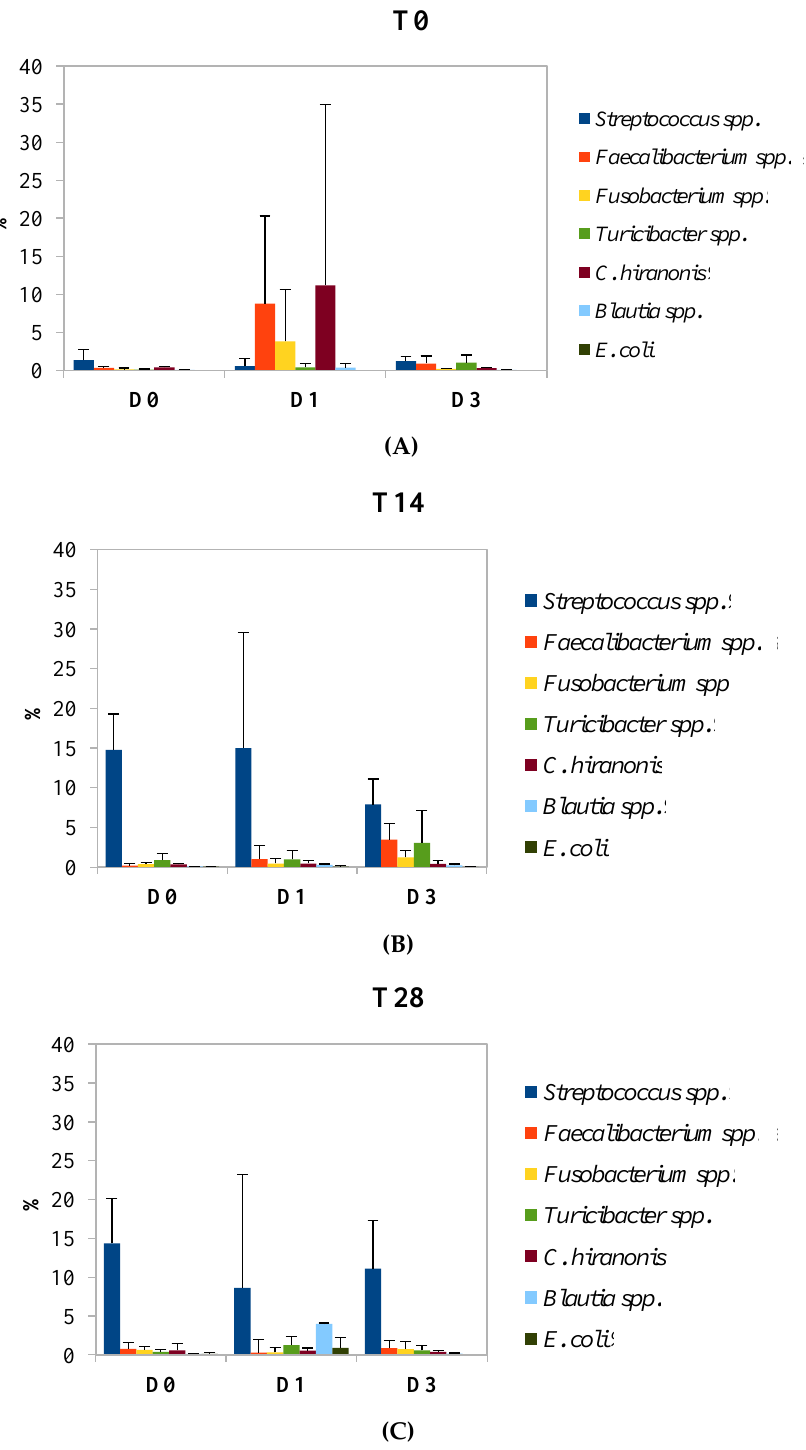
Figure 4. Results obtained from the analysis of the qPCR data. Each panel contains the quantification of the microbial communities researched in the feces of the dogs fed with increasing amounts of proanthocyanidins (D0, D1, and D3). D0: 0 mg / kg live weigh of grape proanthocyanidins; D1: 1 mg / kg live weight of grape proanthocyanidins; and D3: 3 mg / kg live weight of grape proanthocyanidins. ( A ) T0: beginning of the study; ( B ) T14 after 14 days of the study; and ( C ) T28: after 28 days of the study.